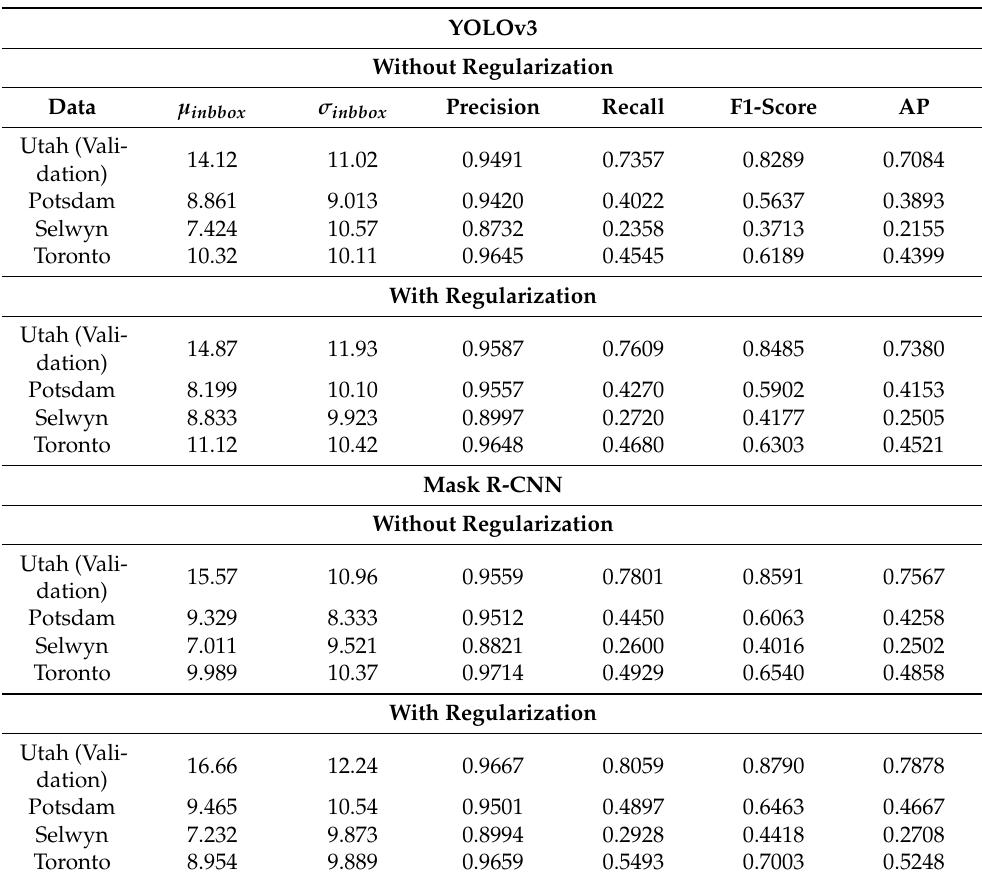
Table 3. µ inbbox , σ inbbox , Precision, Recall, F1-score, and AP of the regularized model on each